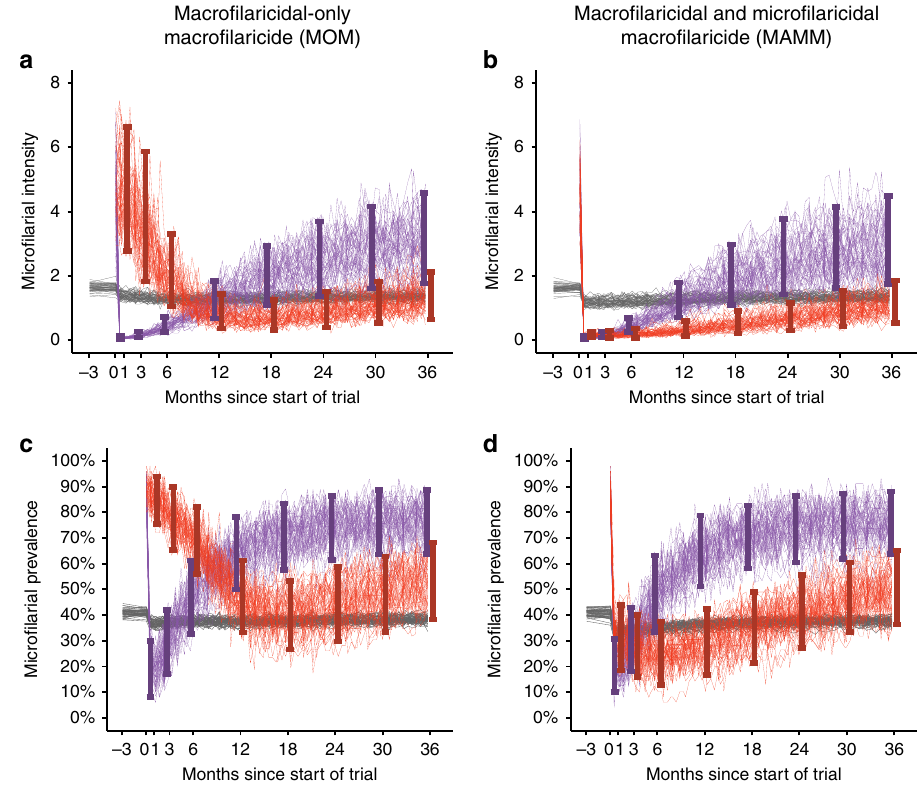
Fig. 3 Parasitological response dynamics in ivermectin-treated and macro fi laricide-treated participants. Each panel depicts the parasitological response dynamics in two 50-participant cohorts treated with either ivermectin (purple lines) or a hypothetical macro fi laricide (red lines) in an ivermectin-naïve lower-end mesoendemic setting. The macro fi laricide has an ef fi cacy of 90% (90% of adult Onchocerca volvulus are killed within three months of treatment) and either macro fi laricidal activity only (MOM, left-hand side ( a , c )) or macro fi laricidal and micro fi laricidal activity (MAMM, right-hand side ( b , d )). The parasitological outcome measure is either the arithmetic mean number of micro fi lariae (mf) per mg of skin (micro fi larial intensity ( a , b )) or the percentage of participants positive for mf (micro fi larial prevalence ( c , d )), both measured by 2 skin snips. Participants were included in the cohort if they were positive for mf (i.e., inclusion criterion was >0 mf/mg of skin). Each thin line represents a single simulation and the vertical error bars indicate the range which captures 95% of the simulations. The grey lines indicate the mean (either mf per mg of skin, i.e., intensity, or presence of mf, i.e., prevalence) in the whole population, which is assumed to comprise 1000 individuals. Note that only eligible participants are treated, i.e., (community-wide) mass drug administration is not